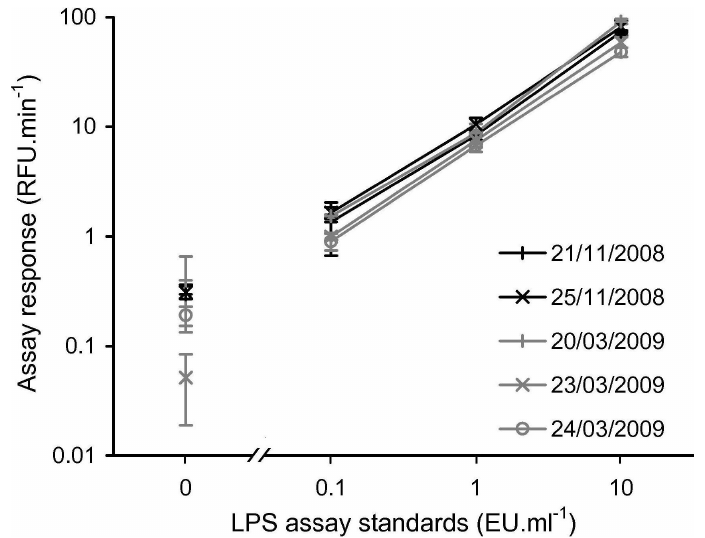
Figure 3. Calibration curves produced on the five days during the 2008 and 2009 field campaigns i.e. , rFC assay response for 10, 1, 0.1 and 0 EU · mL − 1 standards. Error bars indicate ± 1 SD of the assay response from triplicates. Note log scale and broken x -axis to allow for visualisation of the 0 EU · mL − 1 standards.